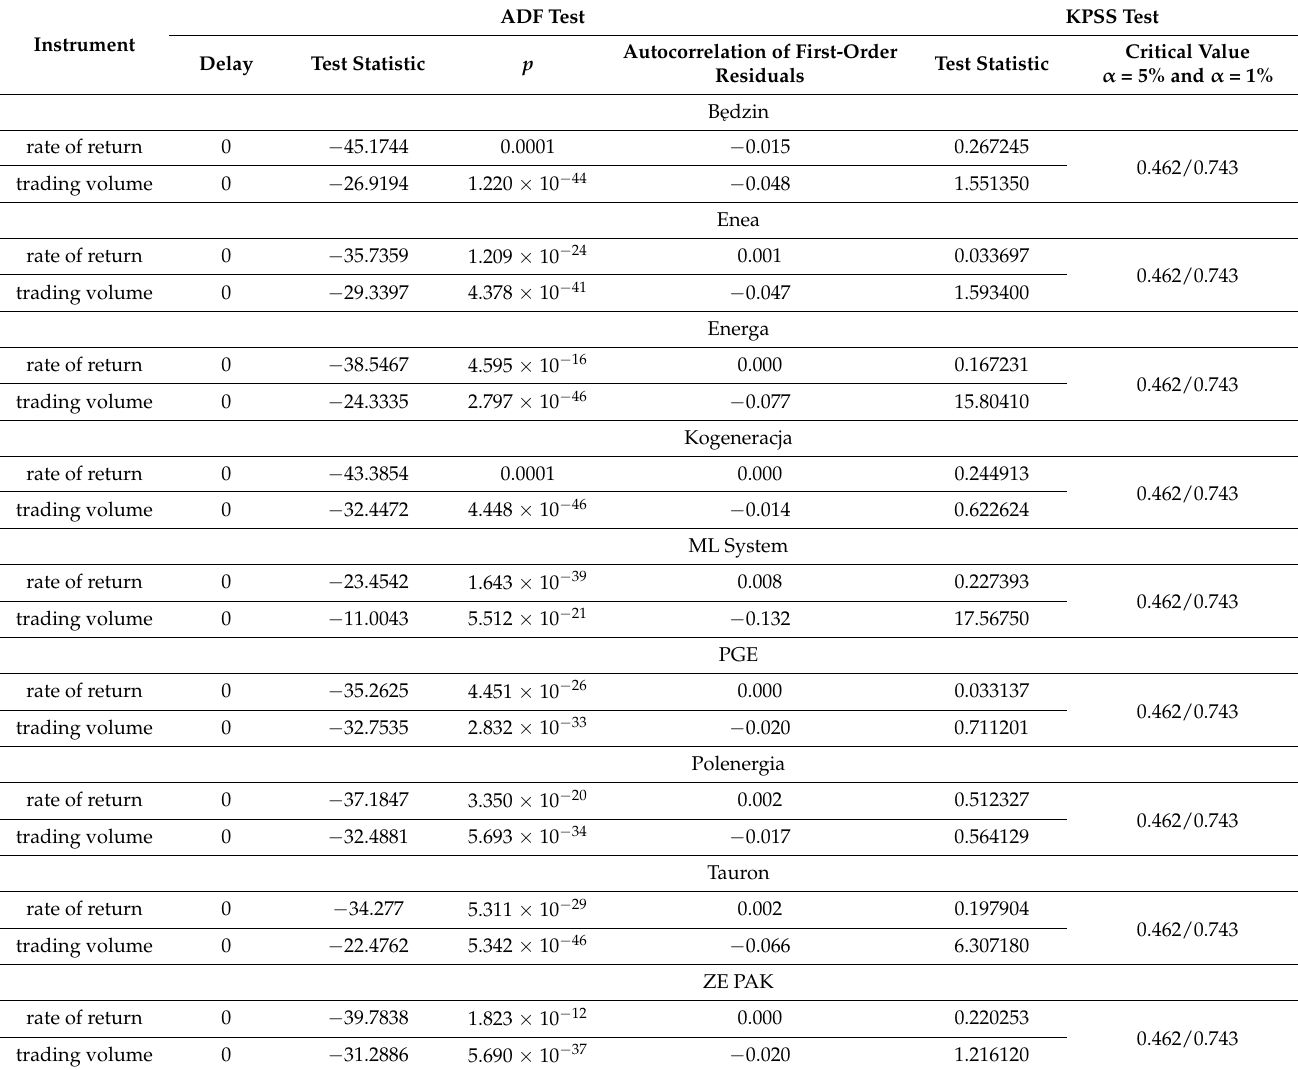
Table 2. Results of stationarity tests of the analyzed stock market time